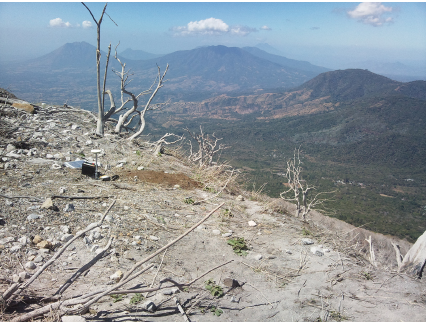
Figure A3. Volcano San Miguel summit GPS station (VSMG), in- stalled on the upper northern flank of the volcano, made by a rein- forced concrete cube buried in the pyroclastic material, where the self-centering benchmark was